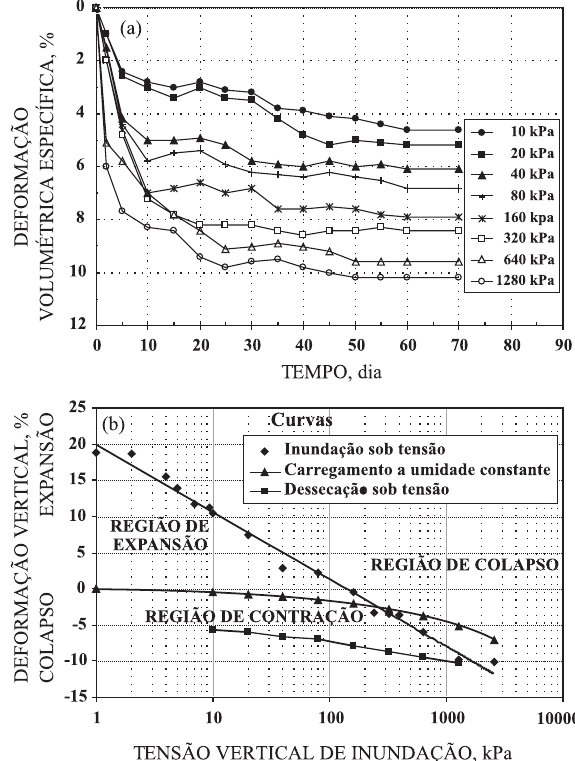
Figura 10. Deformação volumétrica com acréscimo de tensão, dessecação e inundação: (a) deformação volumétrica com acréscimo de tensão e dessecação simultânea; (b) regiões de expansão, colapso e